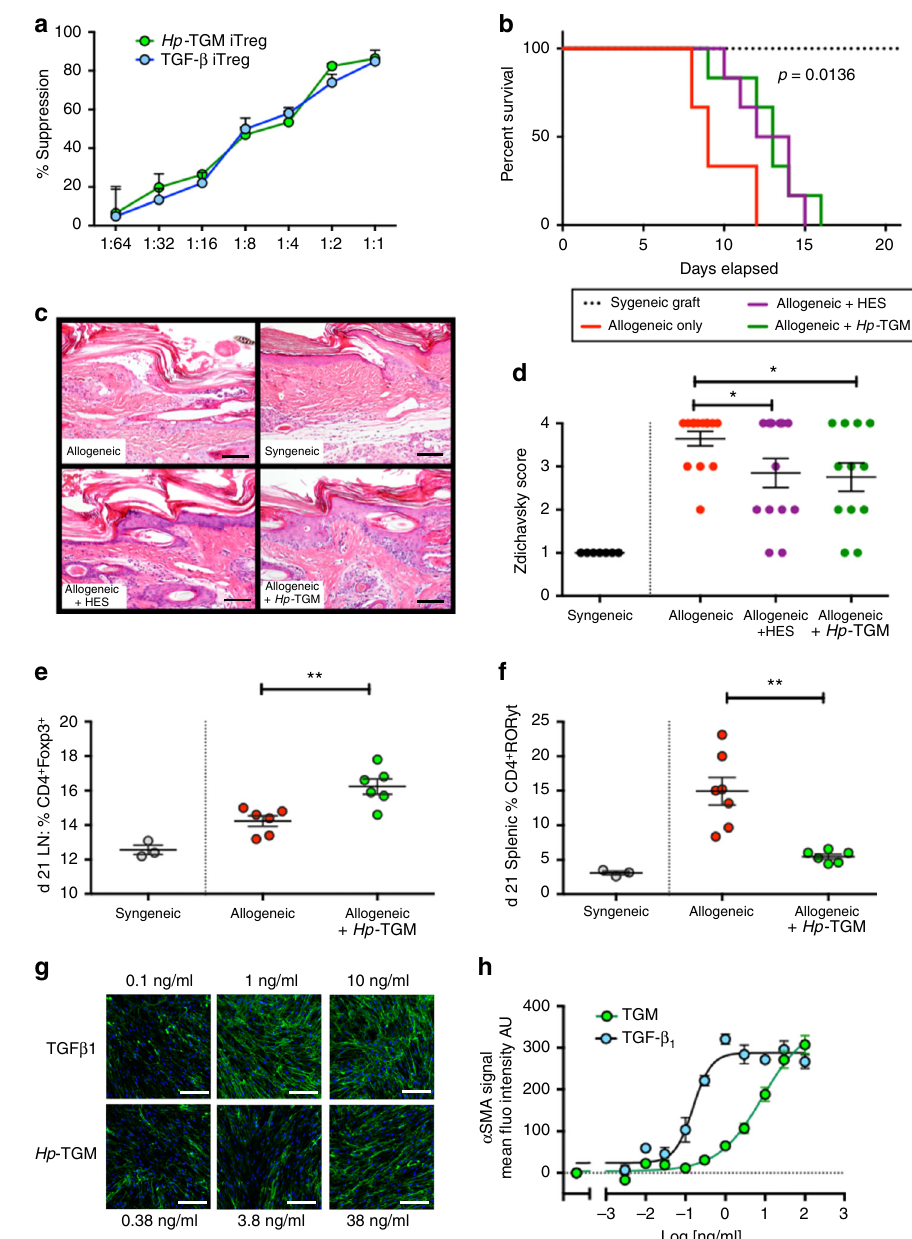
Fig. 6 Hp -TGM drives immune regulation in vitro and in vivo. a Mouse Foxp3 + Treg cells are suppressive in vitro. CD4 + CD25 + GFP + cells, generated as Fig. 4a were isolated by FACS and co-cultured with CD4 + CD25 – GFP – responder cells from Foxp3-GFP mice together with, irradiated APCs and anti-CD3 for 5 days. Proliferation was assessed by thymidine incorporation, and percentage suppression calculated; data are means ± SEM from 3 replicates per concentration and represent two independent experiments. b Hp- TGM prolongs survival of fully allogeneic full-thickness BALB/c to C57BL/6 skin grafts. Kaplan – Meier curve of graft survival: allograft only ( n = 6), allograft + HES or Hp- TGM following implantation of intraperitoneal minipumps, n = 6) and syngeneic controls, n = 3. Mantel-Cox comparison of allograft vs. allograft + Hp- TGM survival curves: p = 0.0136. c , d Histological analyses of graft sites 7 days following transplantation; c , representative images of tissues sections, scale bars = 100 µ m; d , scoring of in fl ammation on 3 sections per graft performed in a blinded fashion: syngeneic control ( n = 7), allograft + control protein ( n = 14), allograft + HES ( n = 13), allograft + TGM ( n = 12); data shown combine two independent experiments, with mean ± SEM shown. HES vs untreated allogeneic control p = 0.0493; Hp -TGM v untreated control p = 0.0397, by unpaired t test. e , f Treg and Th17 CD4 + T cell populations 21 days after transplantation, in e draining lymph node Foxp3 + (syngeneic controls ( n = 3), allograft + control protein ( n = 6), allograft + TGM minipump ( n = 6); two-tailed, unpaired t test: p = 0.0042) and f spleen ROR γ t + (syngeneic controls ( n = 3), allograft + control protein ( n = 7), allograft + TGM minipump ( n = 6); two-tailed, unpaired t test: p = 0.0112). Gating strategy is shown in Supplementary Fig. 6. g , h Fibrogenesis in human lung fi broblasts exposed to TGF β 1 or Hp- TGM, assayed by immuno fl uoresence for collagen deposition ( g , see Supplementary Fig. 8A for quantitative summary) and smooth muscle actin ( h , presented as quantitative summary, see Supplementary Fig. 8B for fl uorescence micrographs). Human collagen I stained with AF488-conjugated scondary antibody (green) and counterstained with DAPI (blue). Scale bars = 200 µ m. Data are means ± SEM from 1 of 3 replicate experiments, with 4 technical replicates per